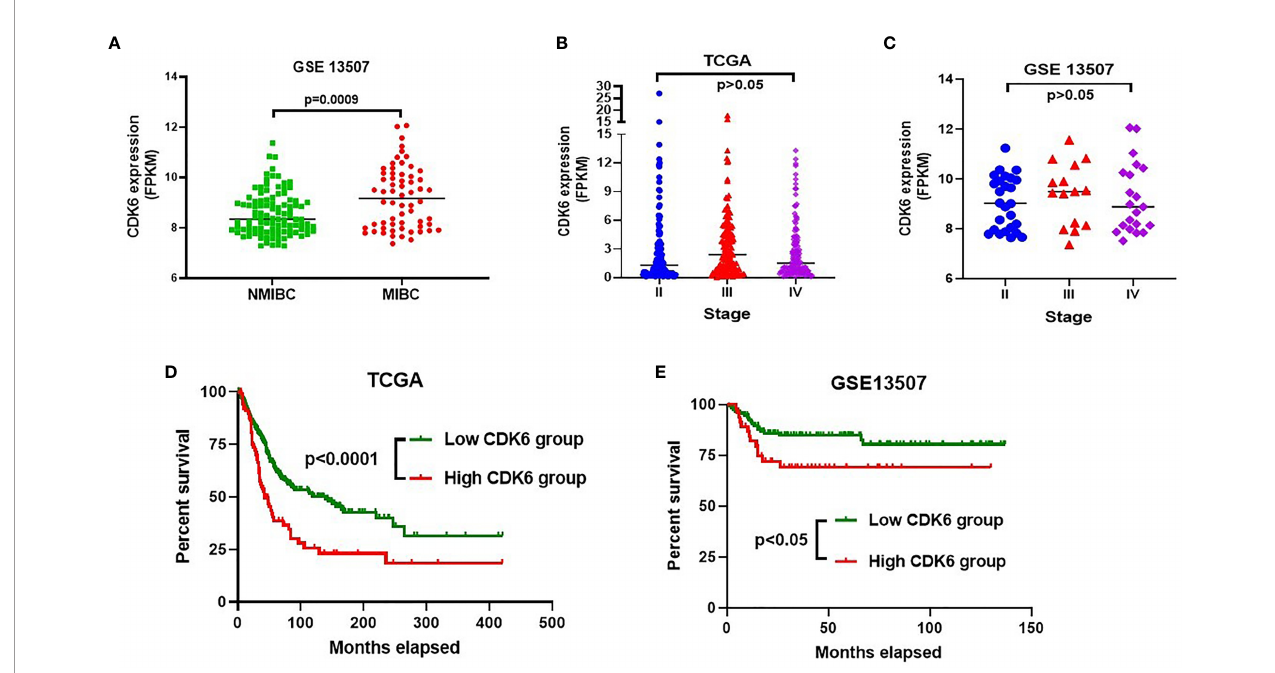
FIGURE 1 | CDK6 transcriptional level analysis in bladder carcinoma (BLCA) from GEO and TCGA database. Muscle-invasive bladder cancer (MIBC) group displayed signi fi cantly higher CDK6 level than that in non-muscle-invasive bladder cancer (NMIBC) group ( p <0.001) (A) . There was no difference on the CDK6 transcriptional level through stage II to IV by analyzing both GSE13507 (B) and TCGA (C) cohorts ( p >0.05). High CDK6 transcriptional cases in 93 (23%) out of 406 cases from TCGA database displayed worse prognosis than that in low level group (n=313) ( p <0.001) (D) . Similarly, CDK6 transcriptional cases in 48 (29%) out of 165 cases also showed worse prognosis than that in low level group (n=117) in GSE13507 cohort ( p <0.05) (E)